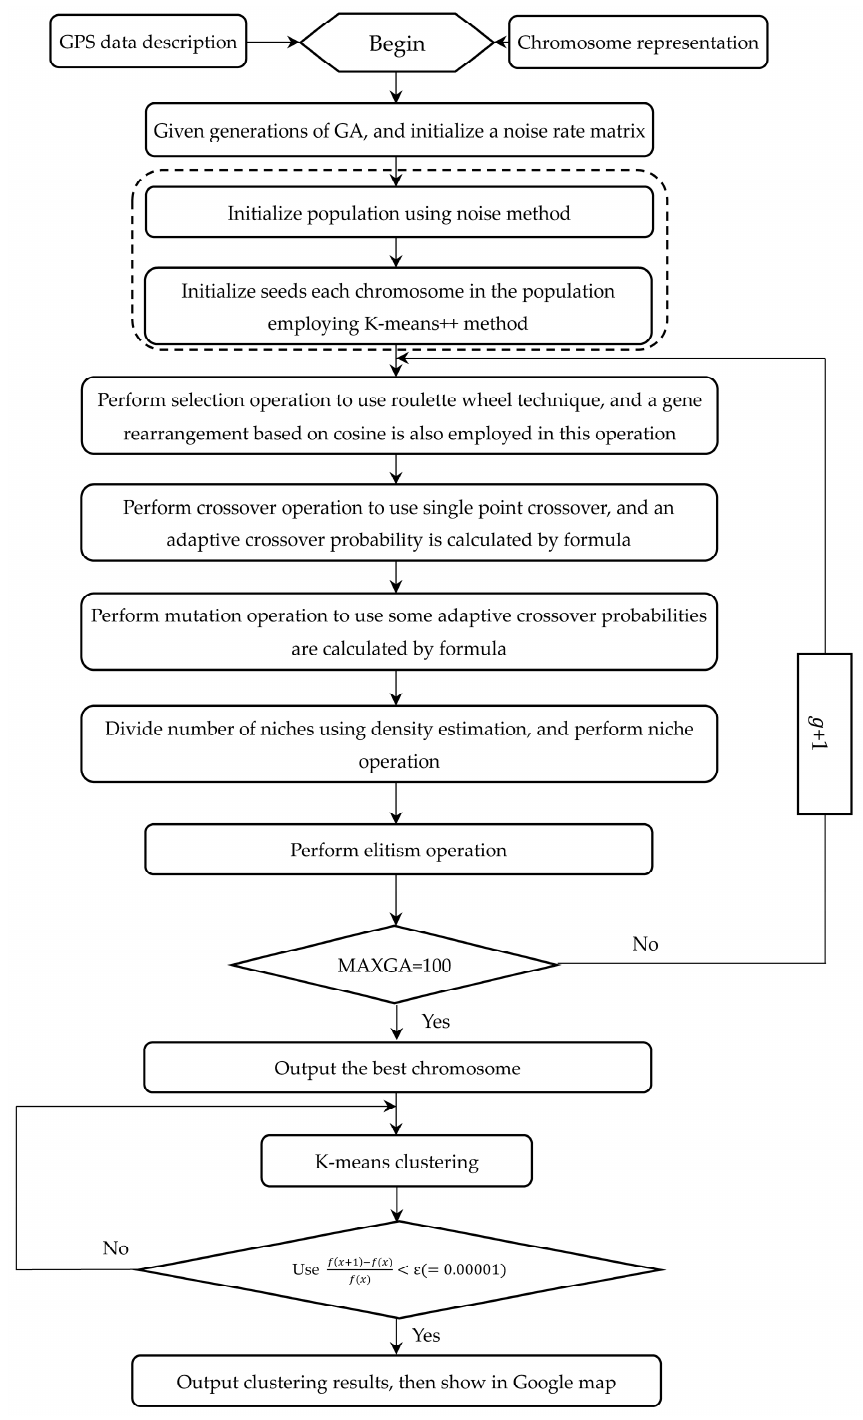
Figure 1. The overall flowchart of NoiseClust.